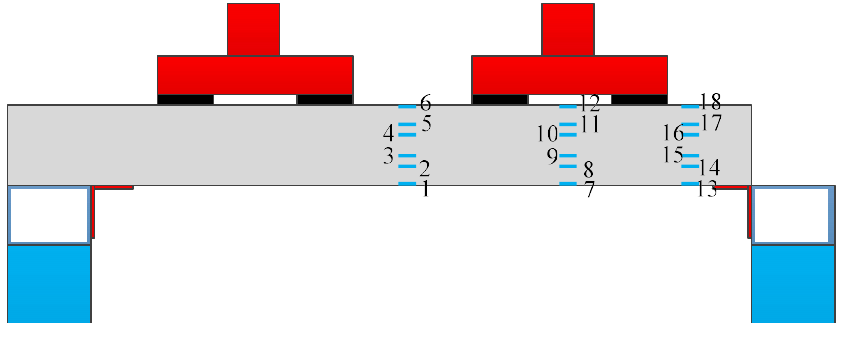
Figure 9. Strain